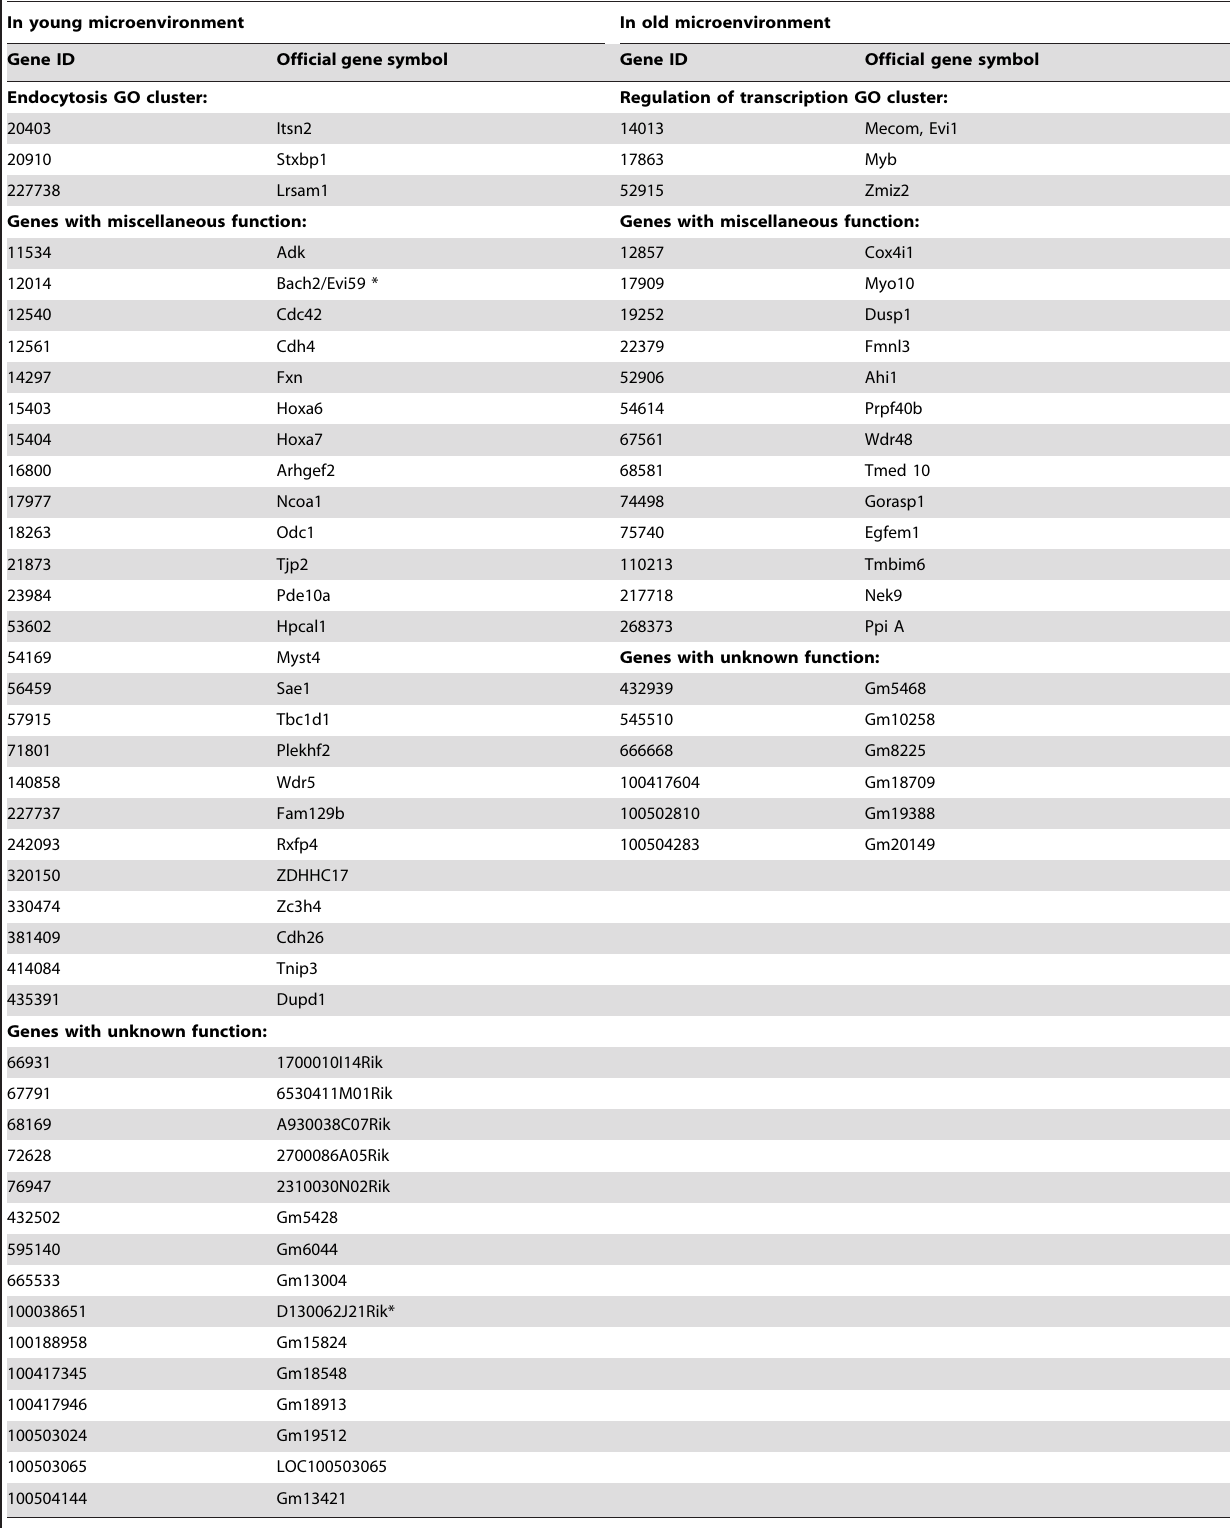
Table 1. Insertion sites in CFCs isolated from young and aged recipient